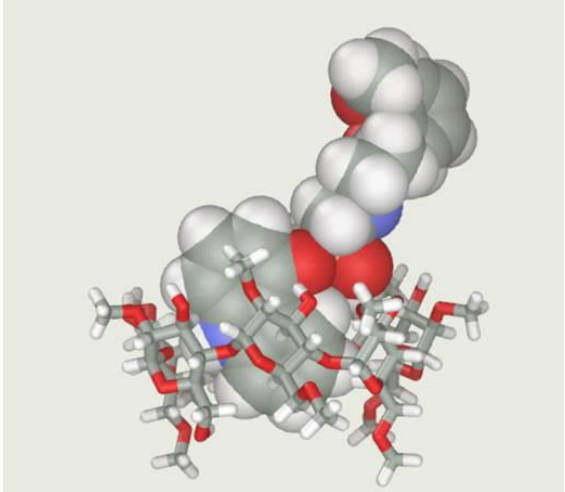
Figure 9. Example of the carvedilol/DIMEB conformation, extracted from a molecular dynamics simulation (Hybrid LS and CD minimization after a 5 ns molecular dynamics simulation at 298 K; OPLS force field with implicit water; Abalone software) .